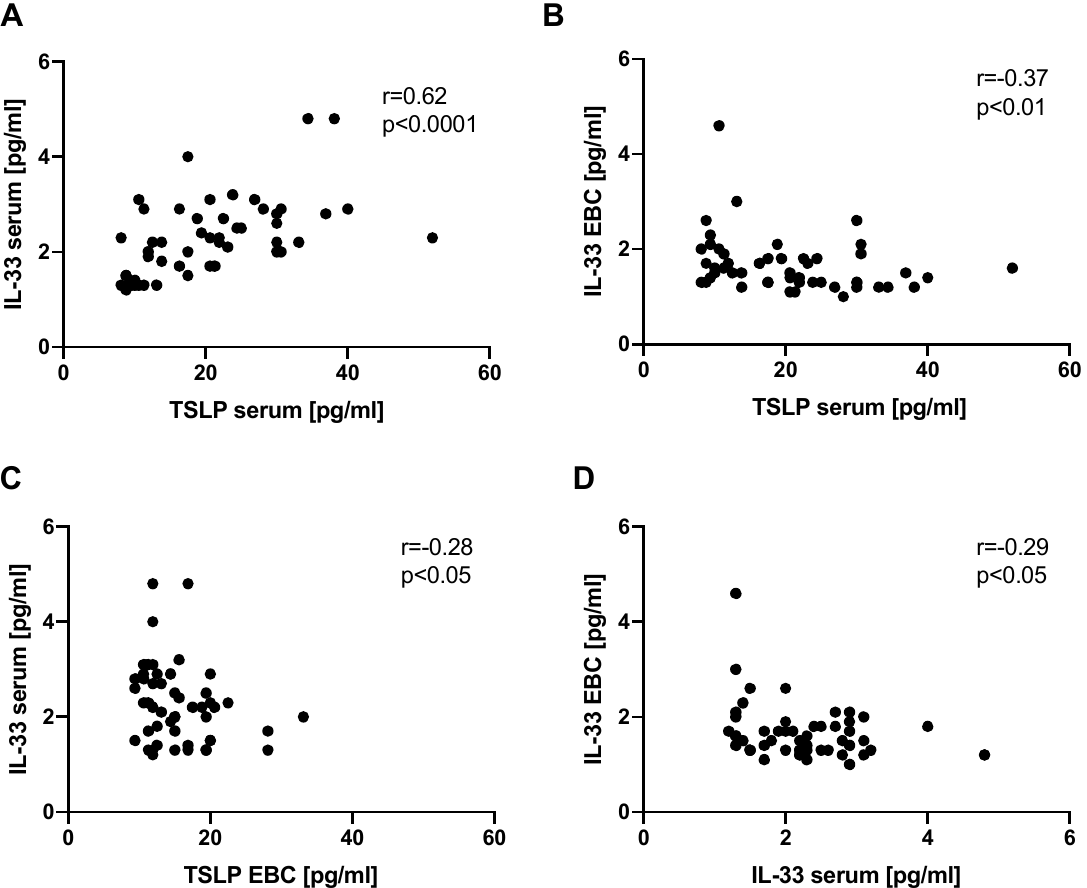
Figure 3. Graphical presentation of significant correlations between the epithelial alarmin levels in the serum and EBC of patients with IPF. Notes: Panels showing the correlation between: ( A ) IL-33 and TSLP serum levels, ( B ) IL-33 EBC levels and TSLP serum levels, ( C ) IL-33 serum levels and TSLP EBC levels, ( D ) IL-33 EBC levels and IL-33 serum levels. EBC—exhaled breath condensate IPF—idiopathic pulmonary fibrosis, IL-25—interleukin 25, IL-33—interleukin 33, TSLP—thymic stromal lymphopoietin. 3.5. Associations between the Epithelial Alarmin Levels and Clinical Measures in Patients with IPF IL-33 serum levels correlated negatively with time since diagnosis ( r = − 0.33, p < 0.05) as well as with CPI score ( r = − 0.31, p < .05). TSLP serum levels also correlated negatively with time since diagnosis ( r = − 0.50, p < 0.001). Significant negative correlations were observed between IL-25 EBC levels and FEV 1 ( r = − 0.32, p < 0.05) as well as TSLP EBC levels and age ( r = − 0.36, p < 0.01). IL-33 EBC levels correlated positively with time since diagnosis ( r = 0.51, p < 0.001). All possible correlations between epithelial alarmin levels and clinical measures in patients with IPF are presented in Table S2. The most relevant and significant correlations are shown in Figure 4.